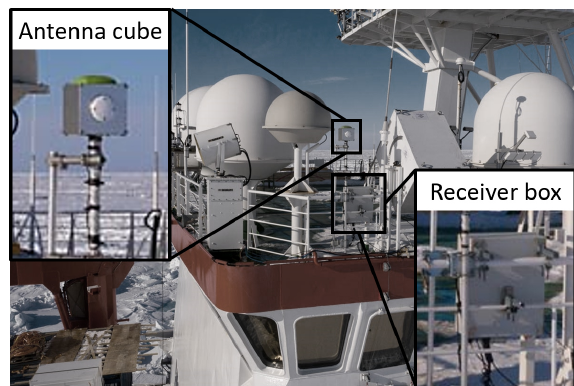
Figure 1. RV Polarstern ’s observation deck in May 2020; the GFZ GNSS antenna is mounted at portside; courtesy Torsten Sachs (GFZ).